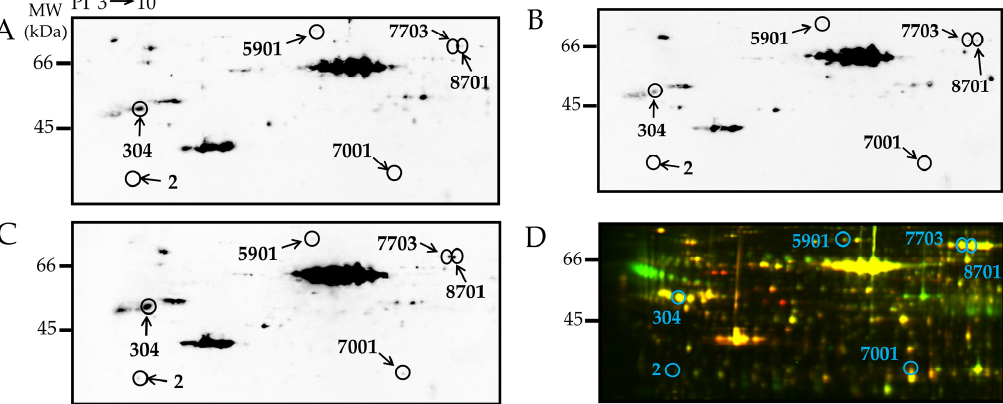
Figure 3. 2D-Oxyblot analysis of epididymal adipose tissues of 25-week-old rats. 2D-oxyblot analysis of adipose lysates of representative ( A ) WKY, ( B ) Lean, and ( C ) CP. Proteins (100 µ g) were treated with DNPH and separated by 2DE, then transferred onto a PVDF membrane. The membrane was incubated with anti-DNP primary antibody, followed by incubation with horseradish peroxidase-conjugated secondary antibody. Reaction was visualized with ECL. The obtained images were processed using PDQuest to match spots and provide spot volumes. ( D ) Blue circles: the corresponding carbonylated spots on the 2D-DIGE. Table 5. List of proteins with increased carbonyl modification in epididymal adipose tissues of 25-week-old CP compared with WKY and Lean.